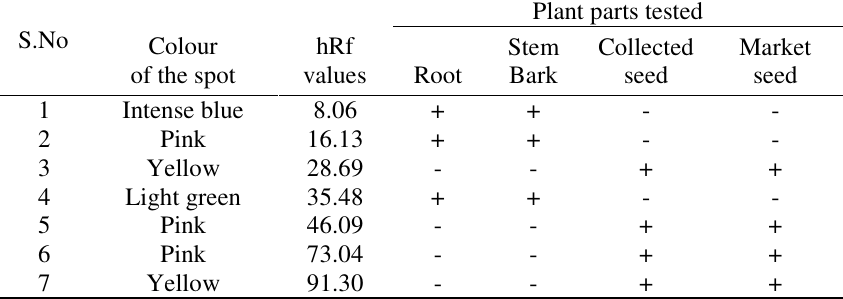
Table 5. Qualitative separation of glycosides of